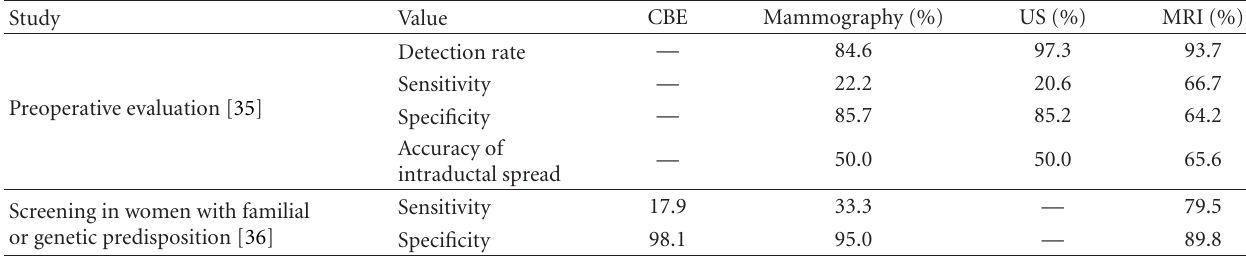
Table 1: Comparative studies of detection techniques. CBE: clinical breast examination; MRI: magnetic resonance imaging; US: